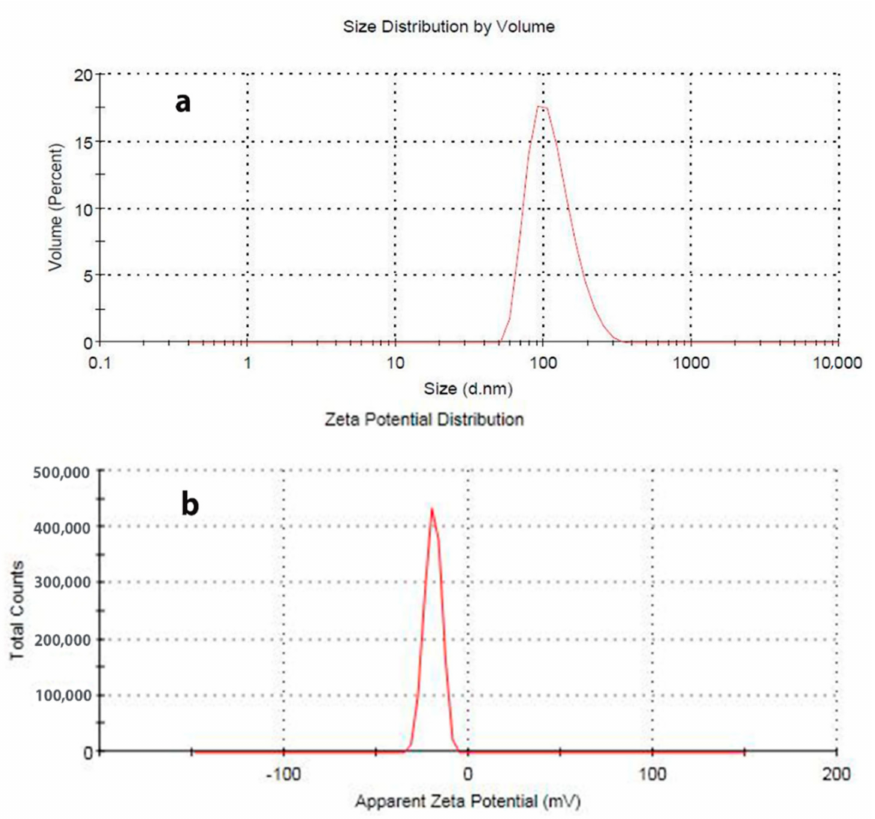
Figure 3. Dynamic light scattering (DLS) ( a ) and zeta potential ( b ) of the obtained SiO2